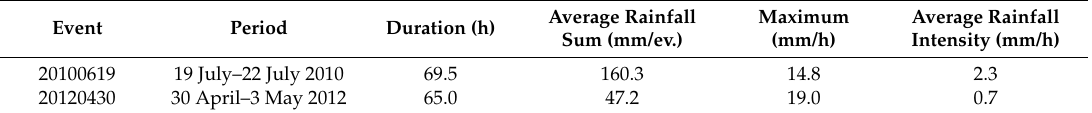
Table 8. Precipitation statistics of the selected events with hourly time step data.